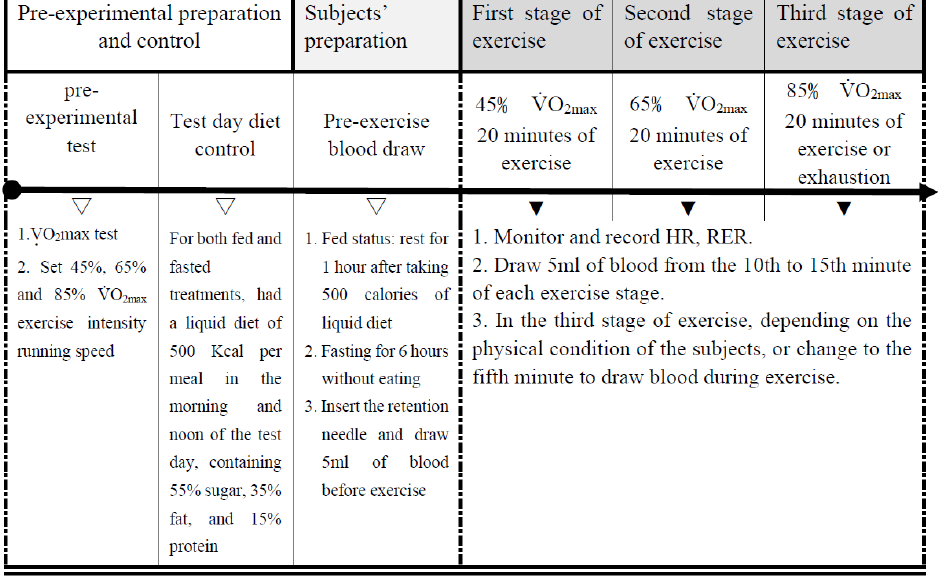
Figure 2. Procedure of the experiment.